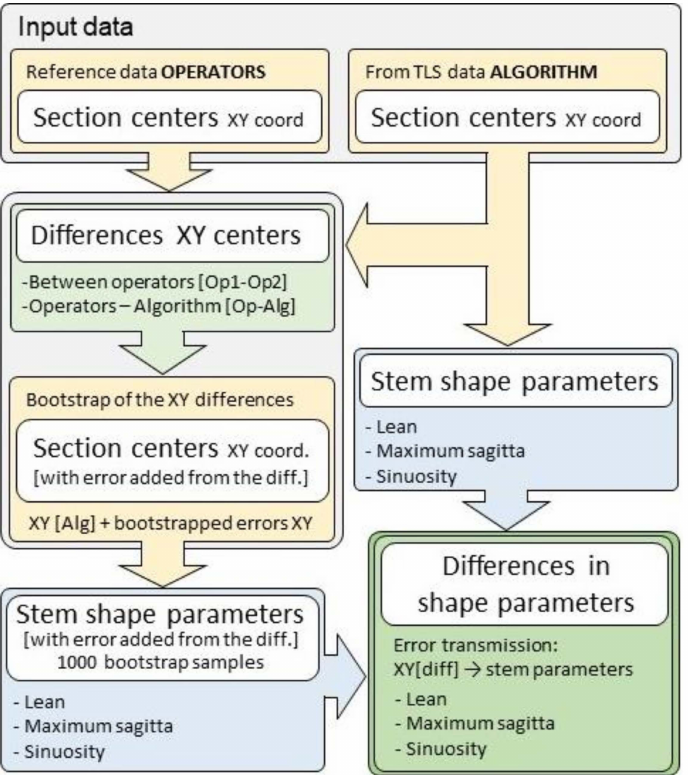
Figure 6. Workflow for the algorithm performance assessment. In yellow: X , Y coordinates of the centers of the sections. In blue: straightness and lean parameters calculated by the algorithm. In green: differences between operators and algorithm in the position of the center of the sections, and in the straightness and lean